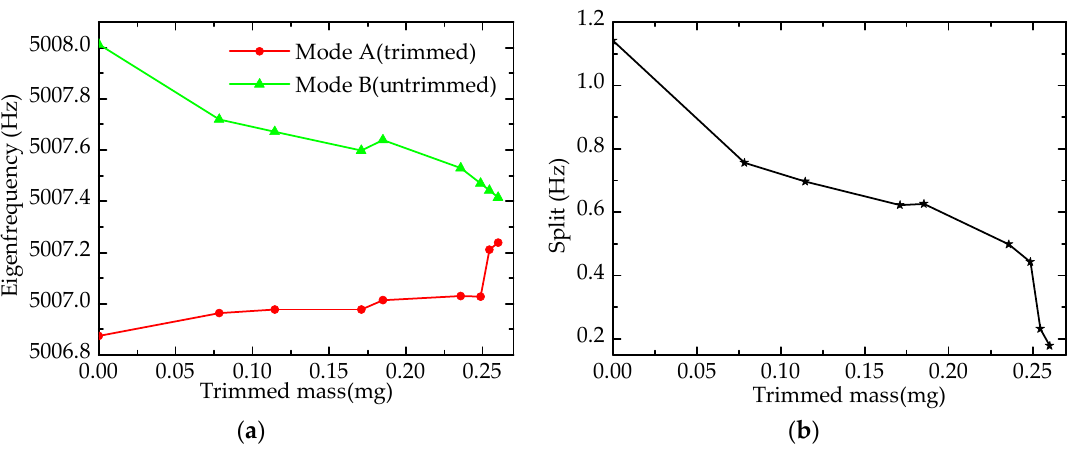
Figure 13. Experimental results of drilling holes on the top of the wall: ( a ) Eigenfrequency; ( b ) Frequency split.